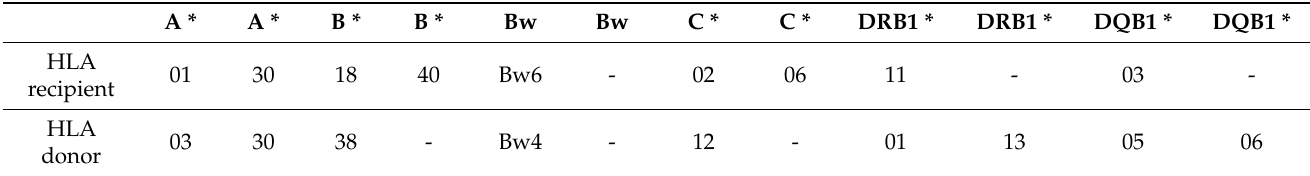
Table 2. Recipient and donor HLA typing. Compatibility between recipient and donor 1 HLA allele out of 10. Mismatch in specificity Bw is highlighted in red (* Molecular